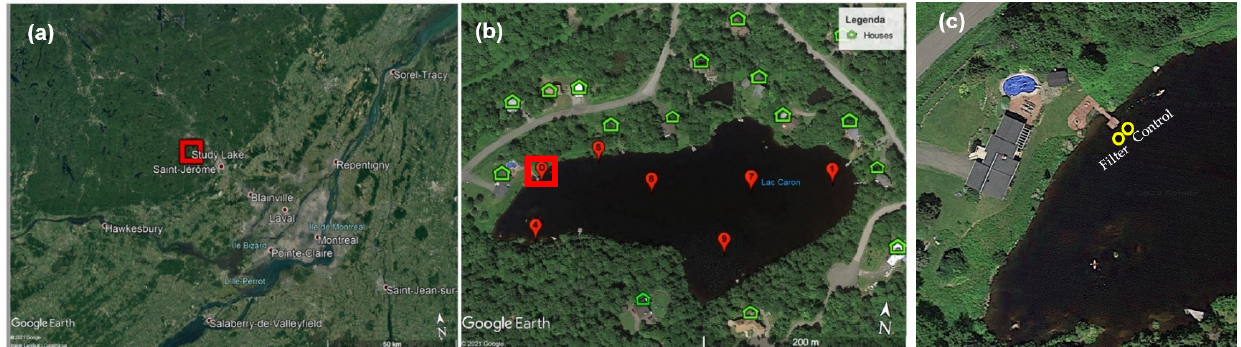
Figure 1. Regional map ( a ) and inset of the Lake Caron map with sampling stations ( b ) with an inset of the experiment approximate locations ( c ).